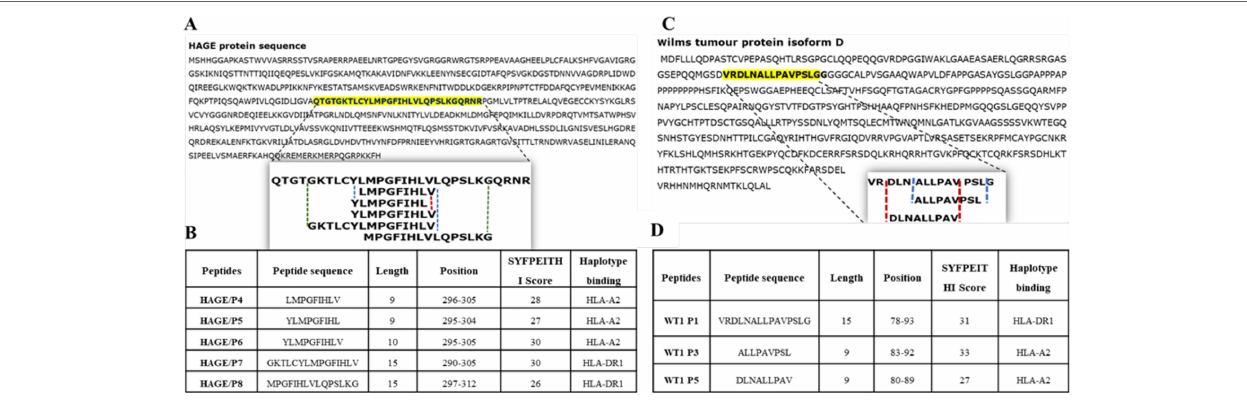
TABLE 2 | Class I and class II peptides sequence derived from the entire length of the HAGE and WT1 proteins.